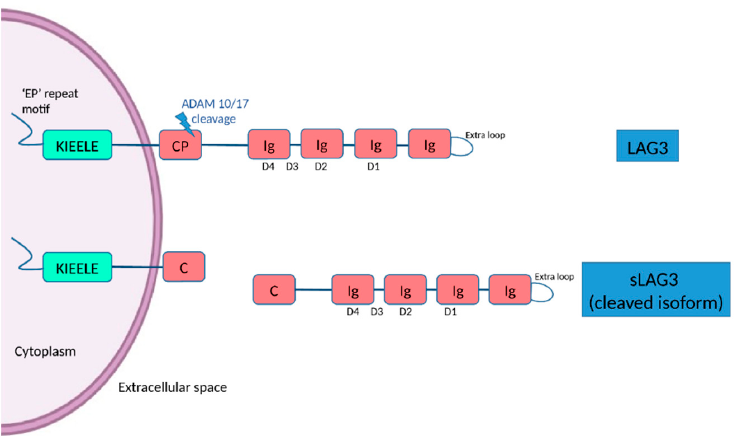
Figure 1. The structure of LAG3 and its cleaved soluble form (sLAG3). LAG3 is a transmembrane protein consisting of 498 amino acids, with four extracellular Ig-like domains (D1–D4) and an intracellular domain, containing an ‘EP’ (glutamic acid-proline) repeat responsible for anchorage and a KIEELE motif, which is required for the LAG3-mediated negative inhibitory signal. LAG-3 can be cleaved within the transmembrane domain at the connecting peptide (CP) by two members of metalloproteases known as ADAM 10 and ADAM 17 to release sLAG-3, which contributes to the regulatory function of